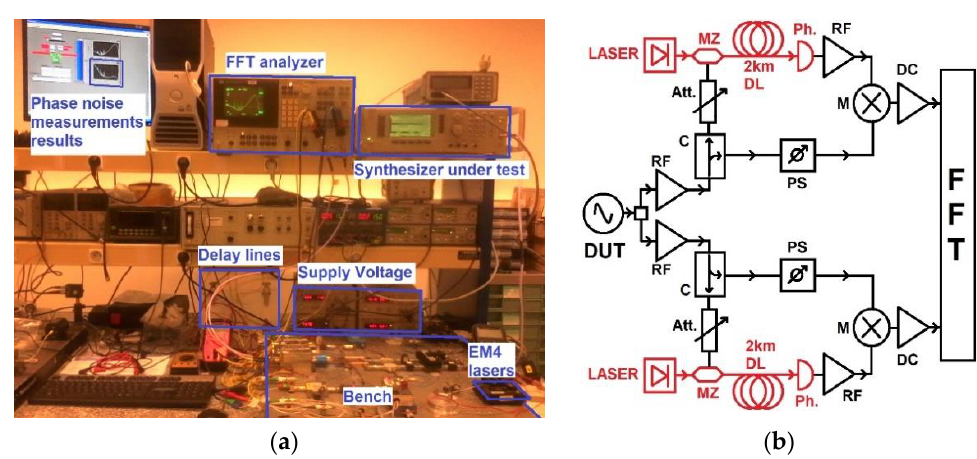
Figure 2. ( a ) Photo of the phase noise measurement bench developed at the laboratory while measuring the phase noise of a synthesizer under test. ( b ) Schematic view of phase noise measurement bench system using a double optical delay line. Optical elements and electrical elements are respectively drawn in red and black colors. DUT—device under test; MZ—Mach–Zenher modulator; DL—delay line; Ph—photodetector; M—mixer; DC—DC amplifier; RF—microwave amplifier; Att.—attenuator; C—directive coupler; PS—phase shifter; FFT—fast Fourier transform analyzer.